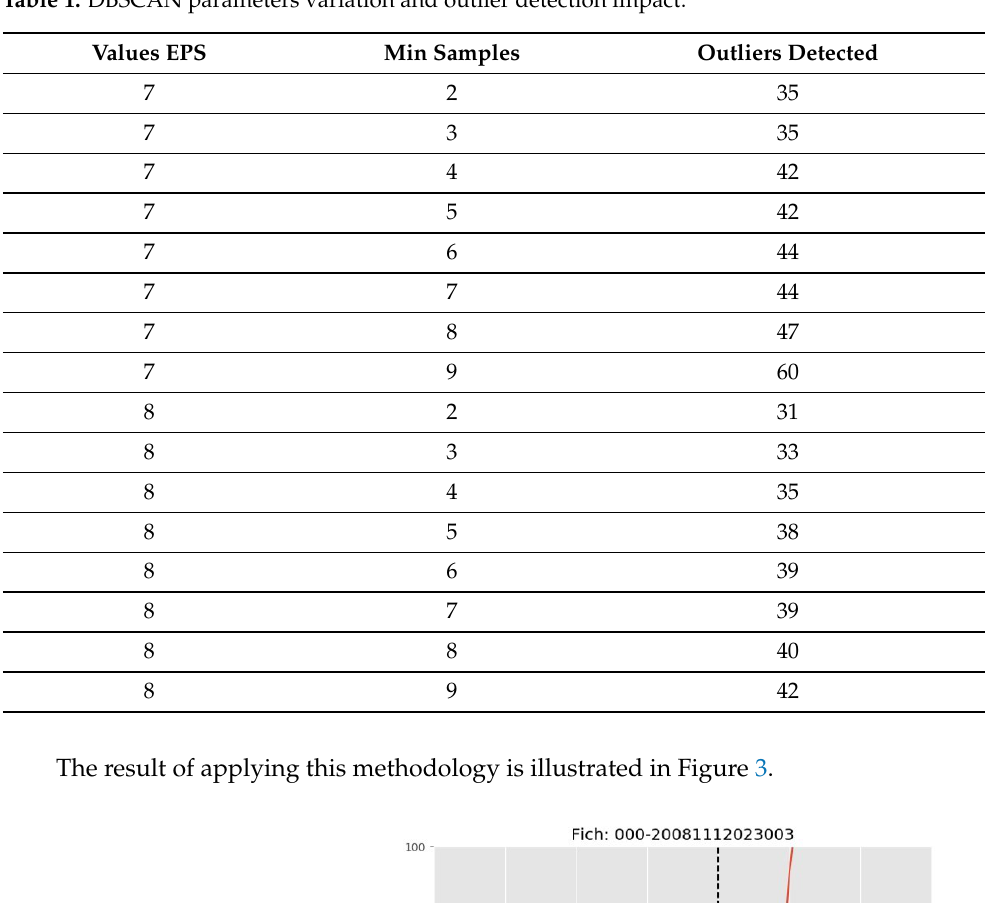
Table 1. DBSCAN parameters variation and outlier detection impact.